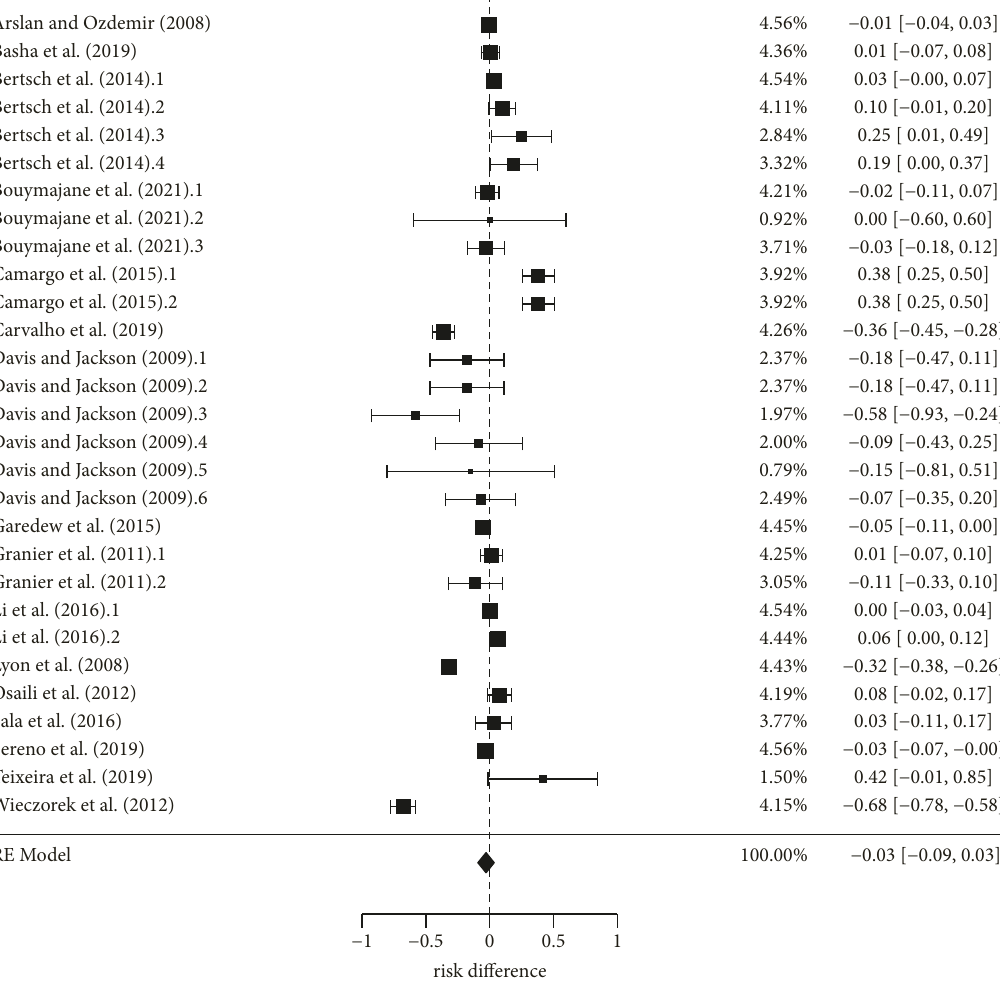
Figure 3: Overall risk difference of antimicrobial resistance to first- and second-line drugs in Listeria monocytogenes . Main estimates and statistics: k � 29; risk difference ( p � 0 . 37); Tau2 � 0.02; heterogeneity ( p < 0 . 01); I 2 � 94%.